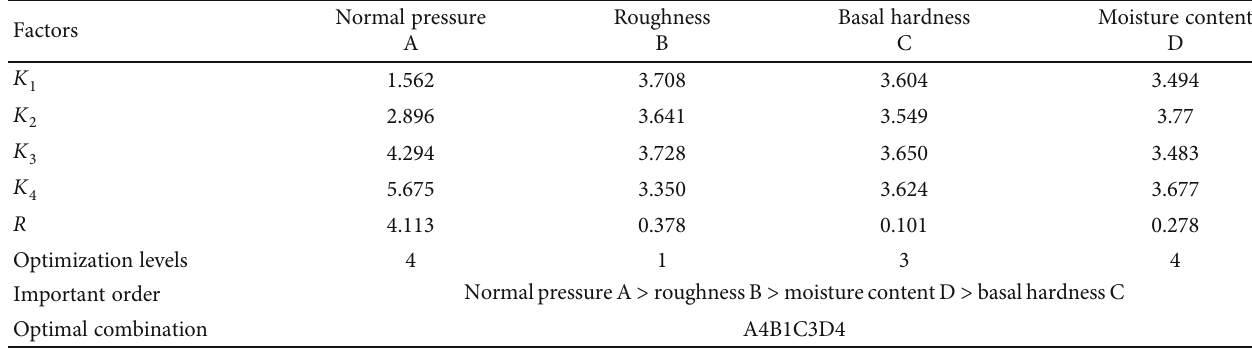
Table 4: Intuitive analysis results of shear strength.